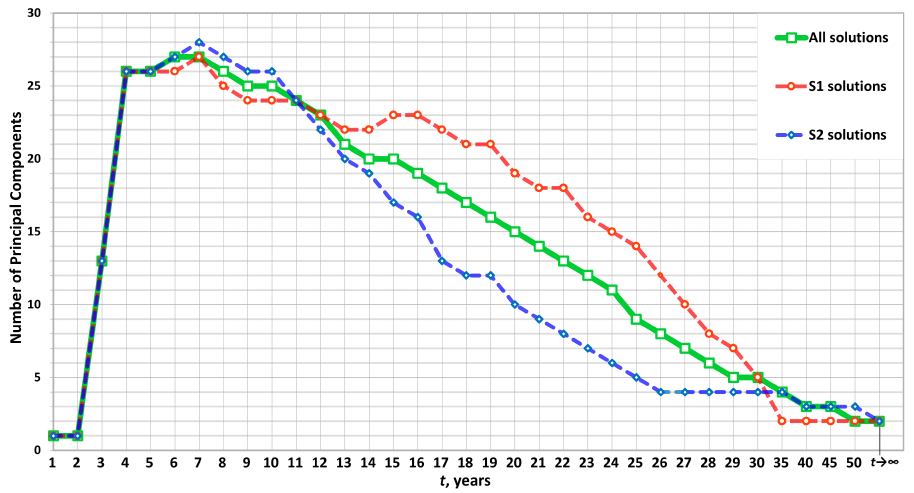
Figure 10. The number of principal components needed for the approximation with 95% precision.